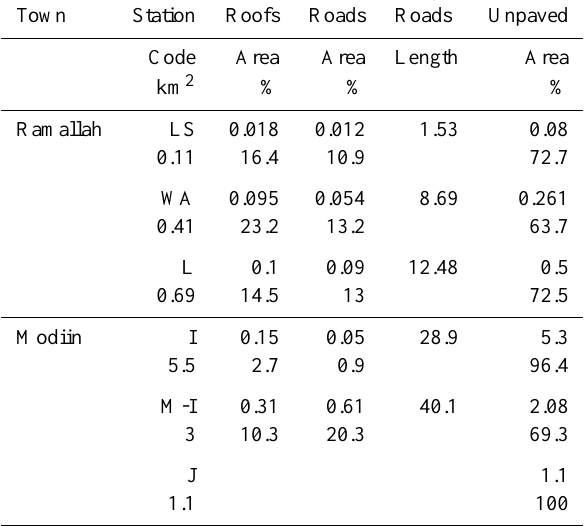
Table 2. Catchments area characteristics for each of the hydromet- ric stations. The Area is in km 2 and the Length in km. The % values refer to the percentage of the specific landuse